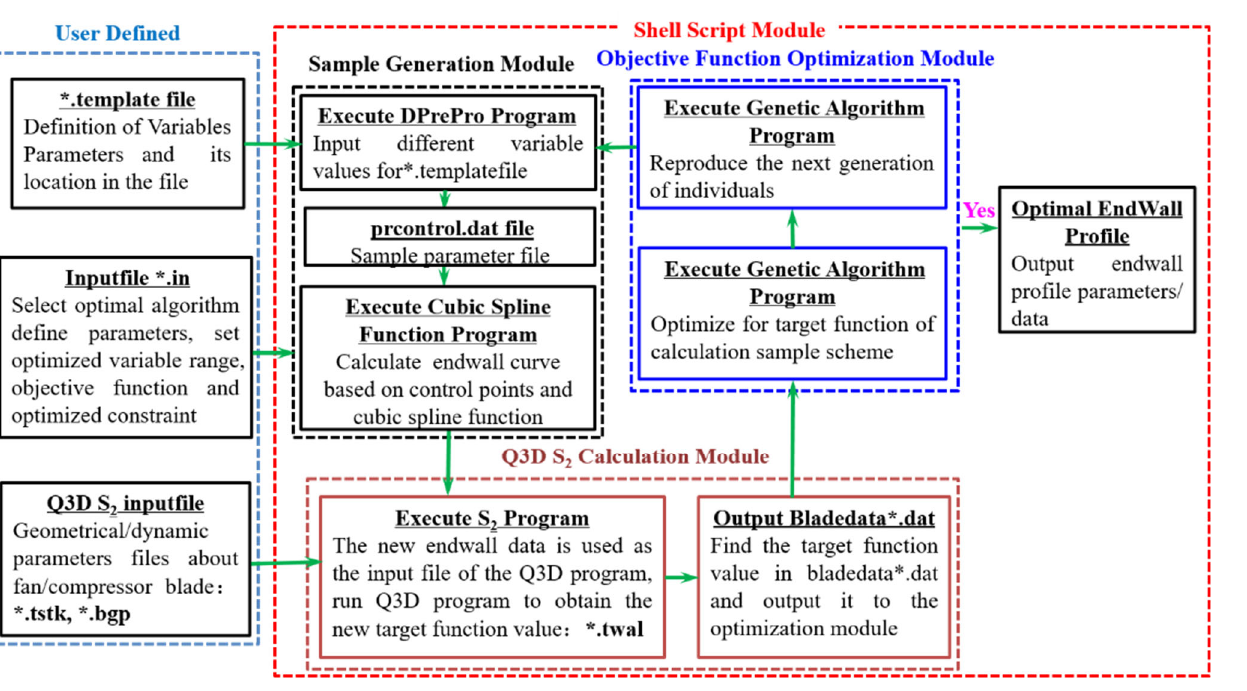
Figure 8. The stream map of the optimization platform.